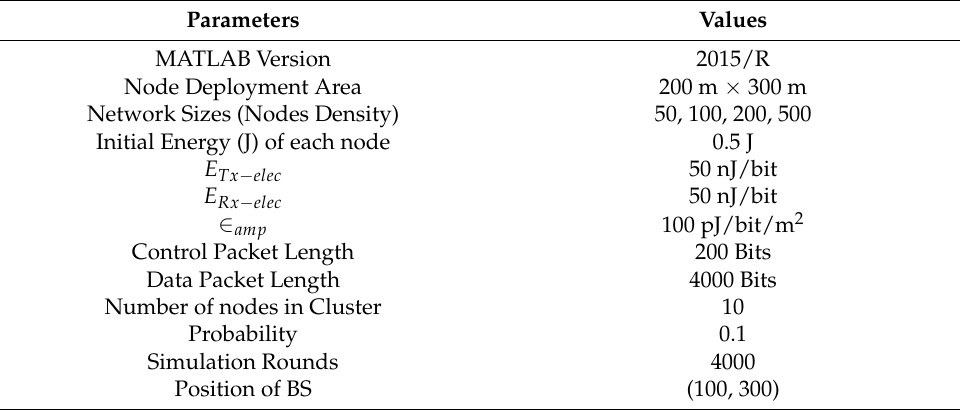
Table 4. Summary of simulation